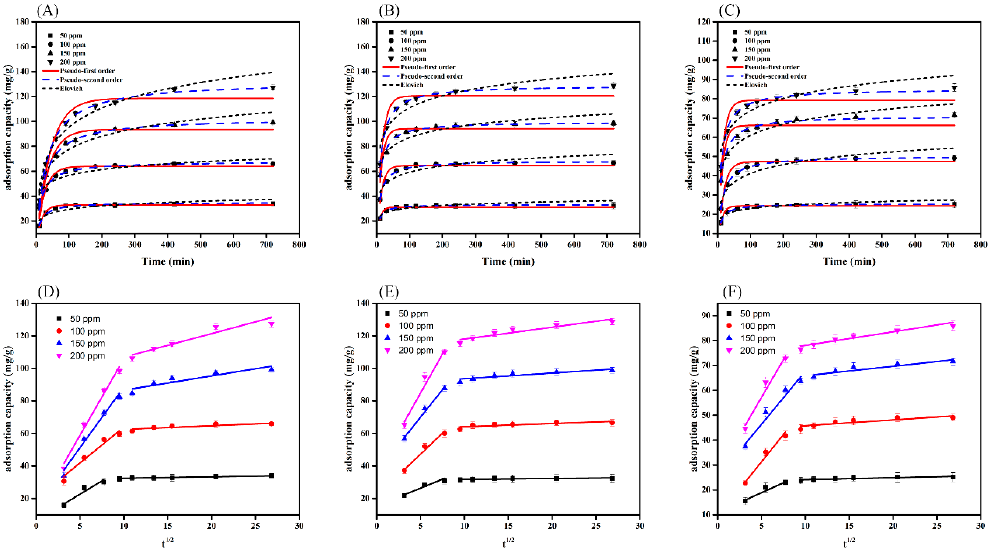
Figure 5. Adsorption kinetic analysis with different concentrations of Direct red 5B (DR5B) ( A , D ), Direct blue 71 (DB71) ( B , E ), and Reactive black 5 (RB5) ( C , F ) and using different kinetic models.